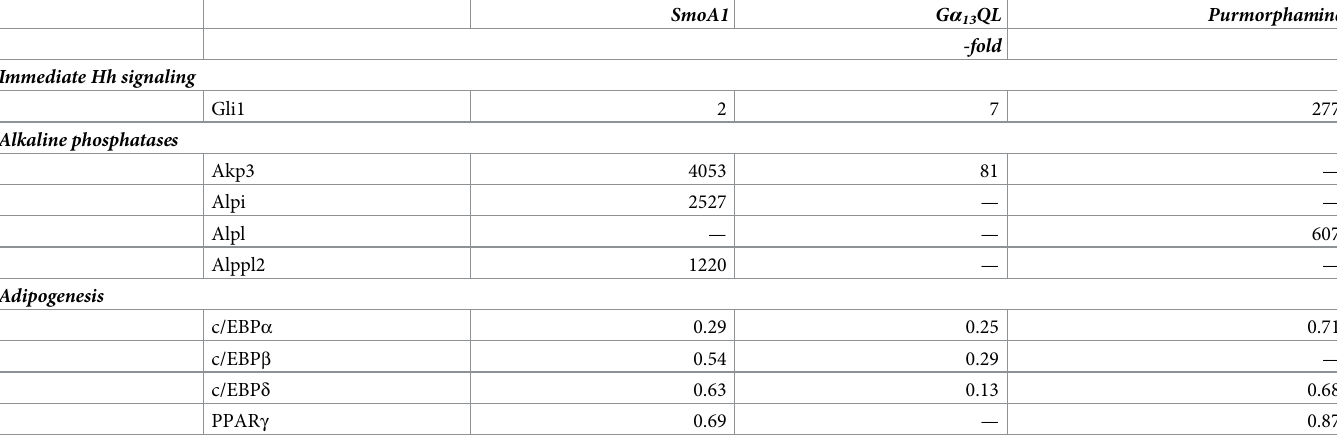
Table 1. Changes in transcripts for selected genes in C3H10T1/2 cells following introduction of SmoA1 and G α 13 QL, or exposure to purmorphamine.